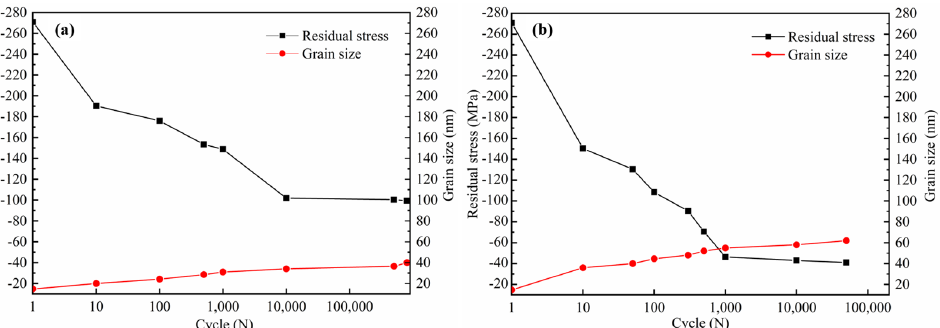
Figure 12. Residual stress and grain size variation with cycle numbers under different stress ampli- tudes: ( a ) 210 MPa; ( b ) 320 MPa.